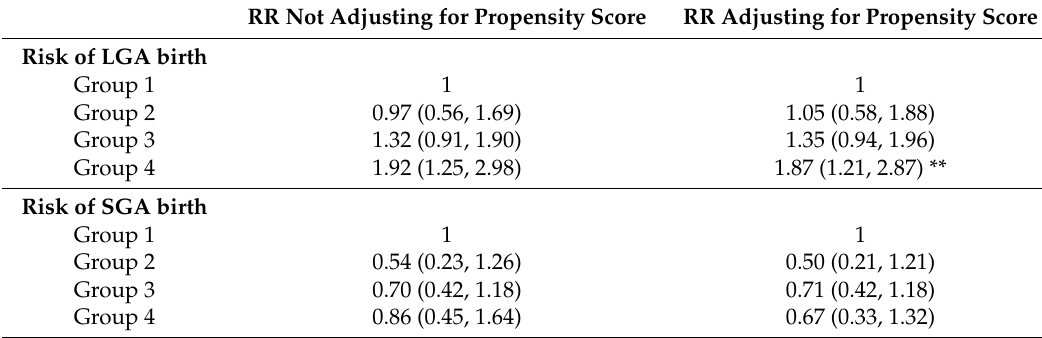
Table 4. Relative risks * of LGA and SGA in pregnant women according to folic acid supplementation after early pregnancy (adjusting for propensity score or